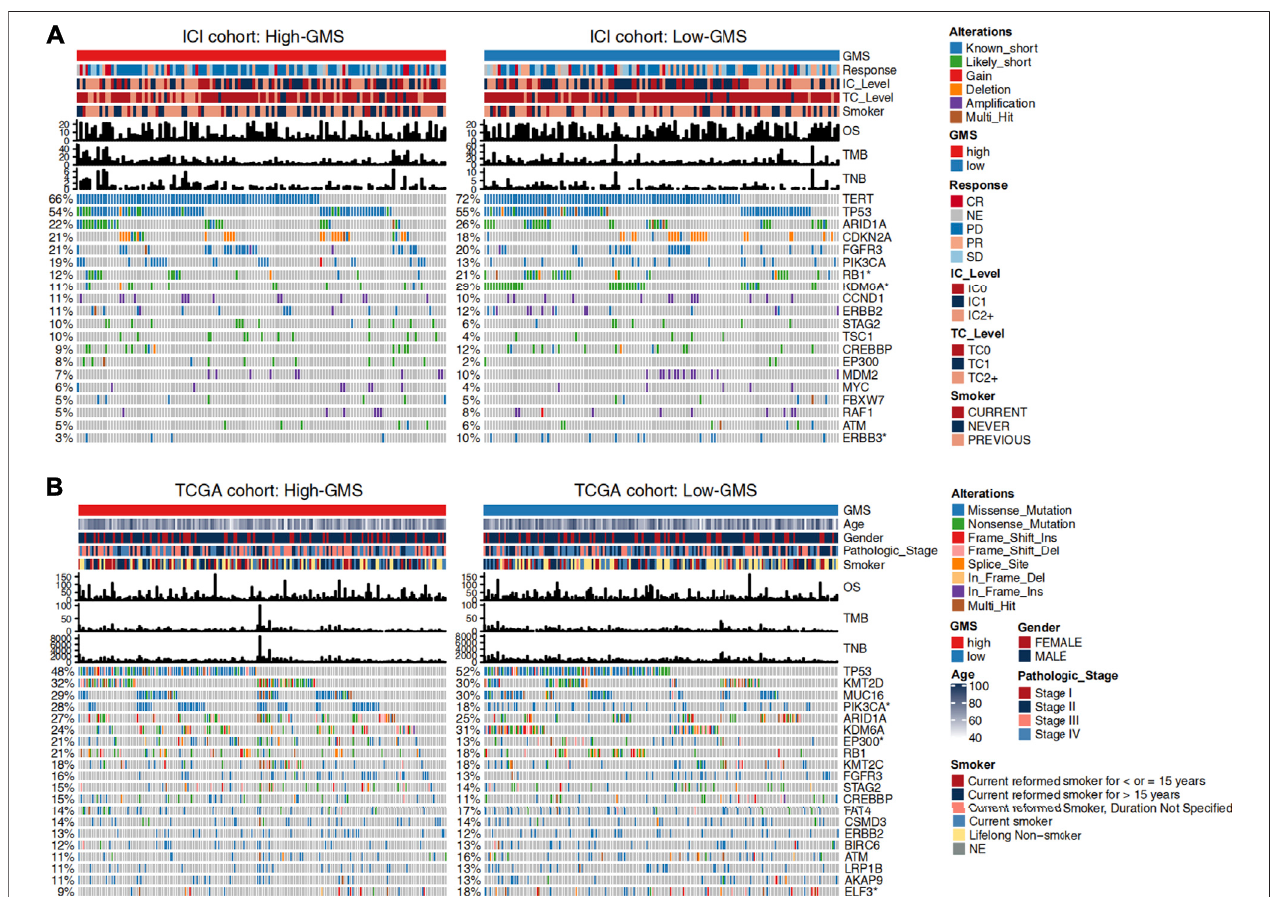
FIGURE3| ClinicalinformationandgenemutationlandscapeofUCpatientsintheICIcohort (A) andTCGAcohort (B) .Themainportionofthe fi gureshowsthetop 20drivergenes ’ alterationtypeswiththehighestmutationrates,andtheleftbarplotindicatesthemutationrateofeachdrivergene.Genesmutatedsigni fi cantlybetween high-GMSandlow-GMSpatientsaremarkedwithasterisksaftertheirname.TheupperbarplotshowsGMSsubgroups,OS,TMB,TNB,andotherclinicalinformationof UC patients, and the color codes and annotations are shown in the legend.